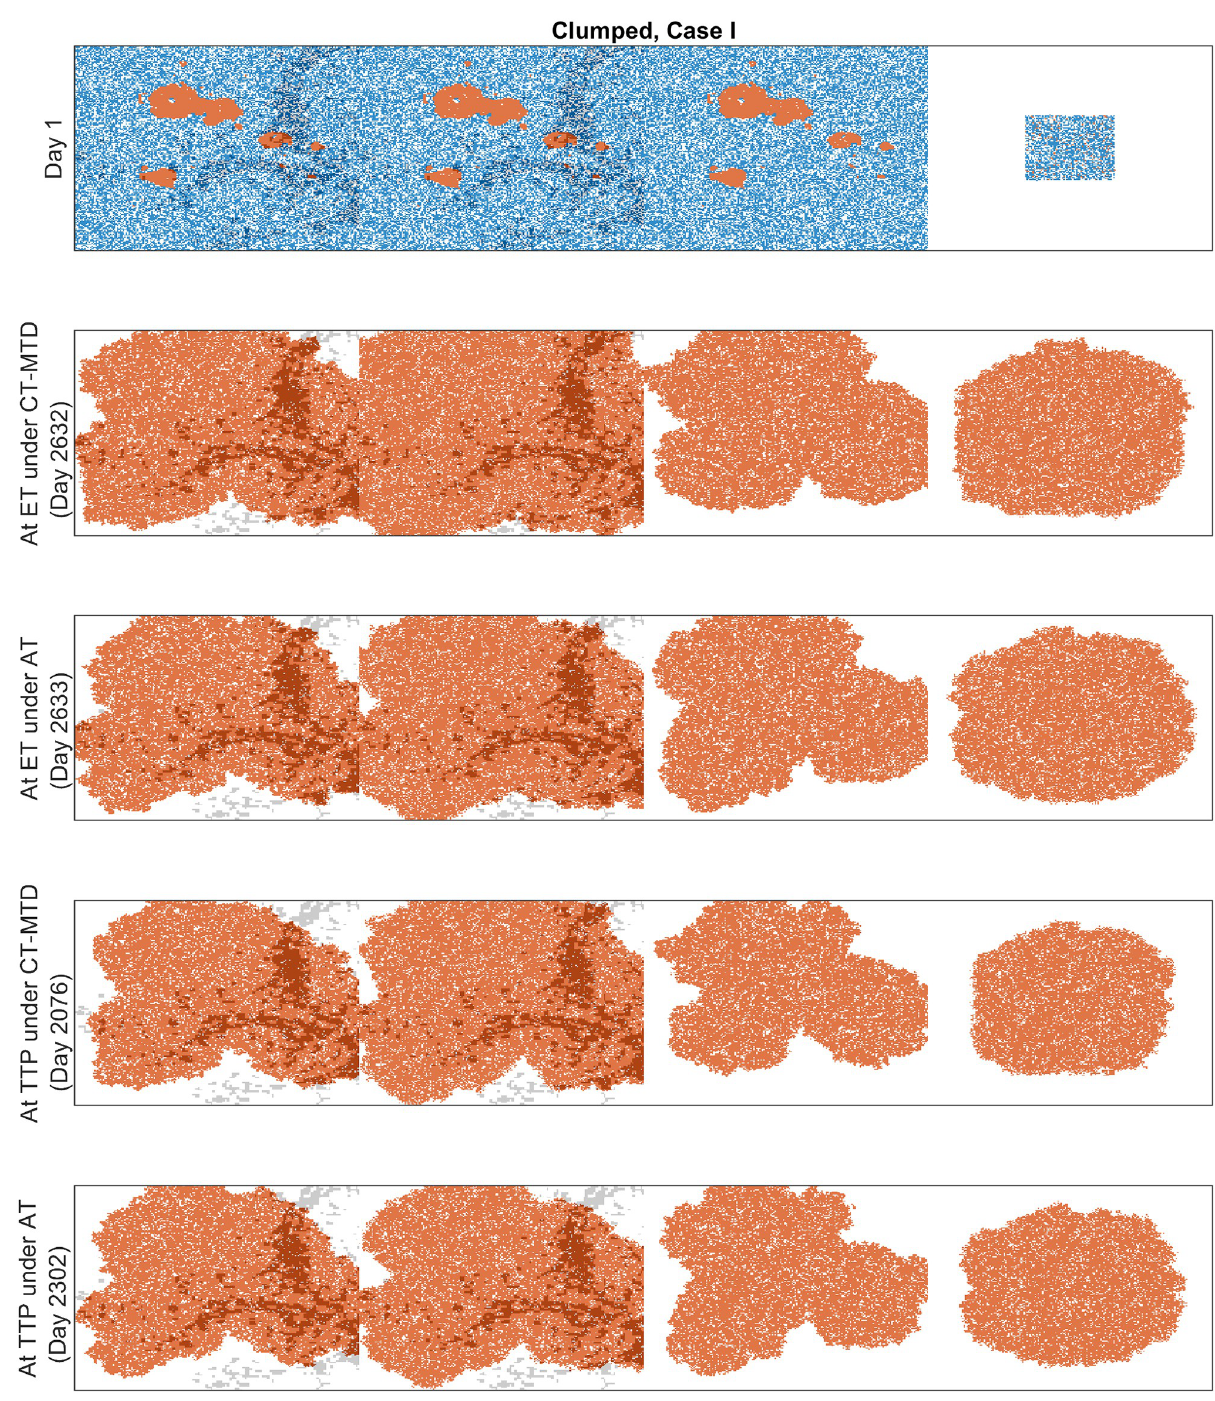
Fig 15. Cell configurations at the ET and TTP under CT-MTD and AT for Case I with the clumped invisible metastasis. The red, blue, and white dots correspond to R-cells, S-cells, and empty sites. The gray dots show the sites that are accompanied by fibroblasts.